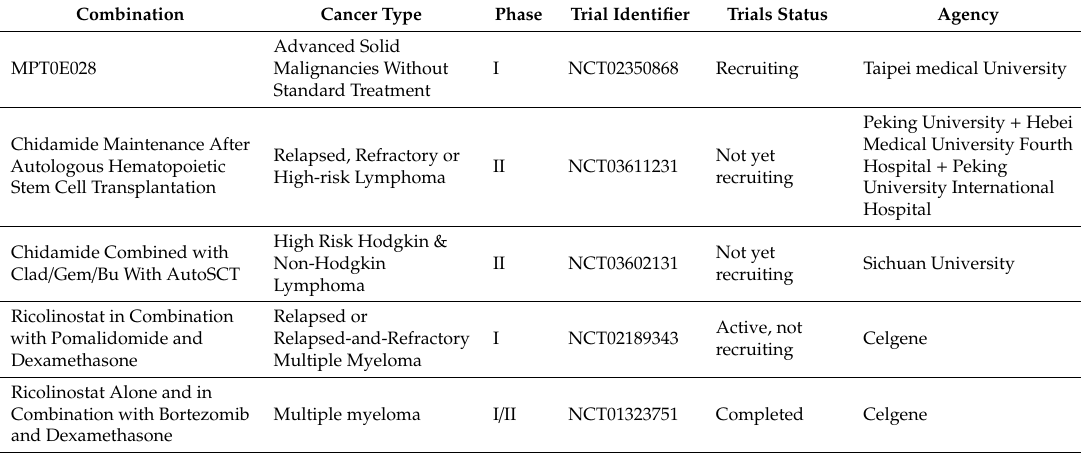
Table 4. Examples of clinical trials with selective HDACis in combination with immunotherapeutic / chemo-immune